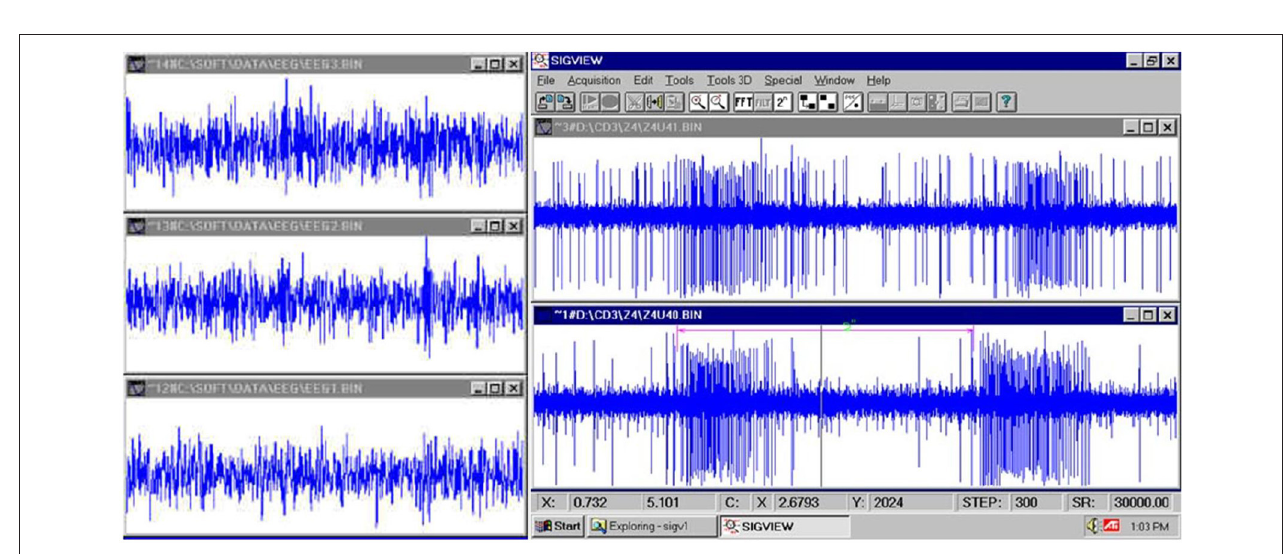
FIGURE 3 | Garden snail neuron activity (Kesi´c et al., 2014).